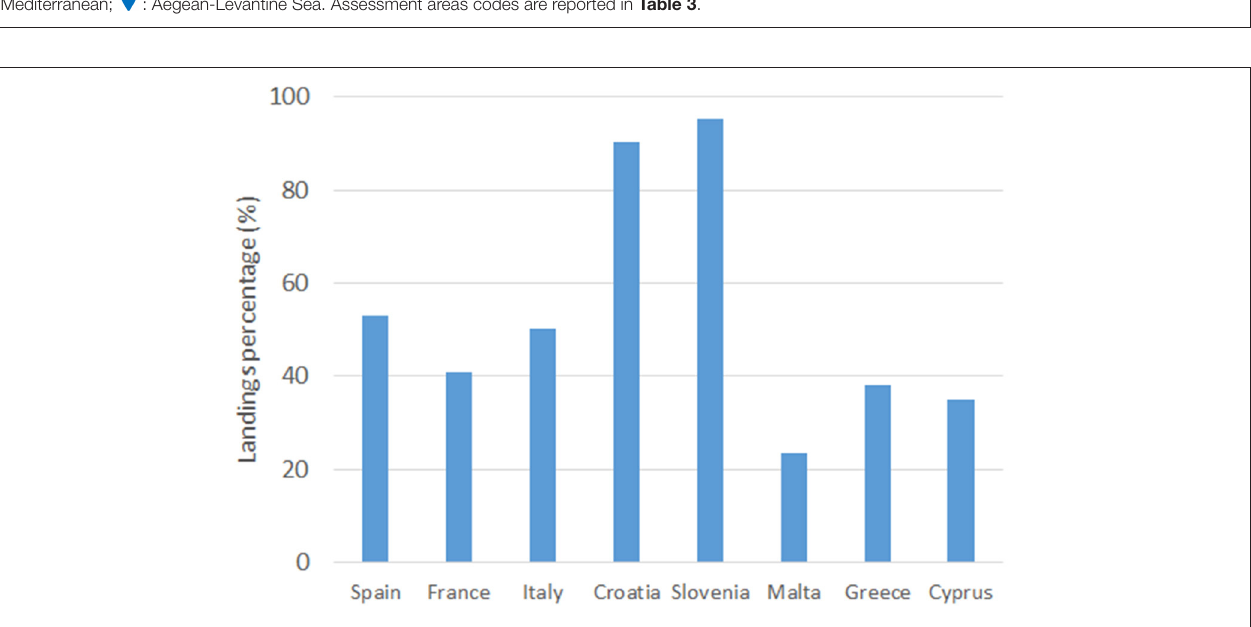
(2006) were higher than those assessed within the IA at the subregional level, apart from the case of WMS. It is also worth noting that when IA was carried out, only a minor share of